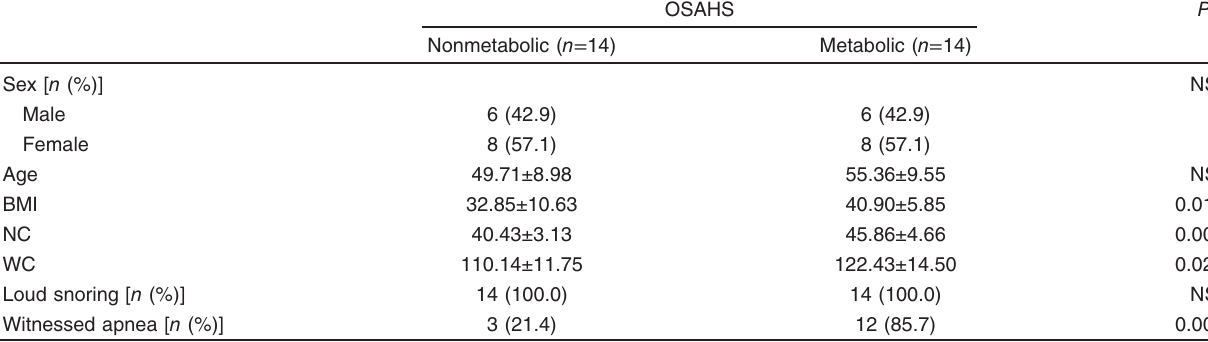
Table 2 Comparison between the two studied groups according to baseline characteristics